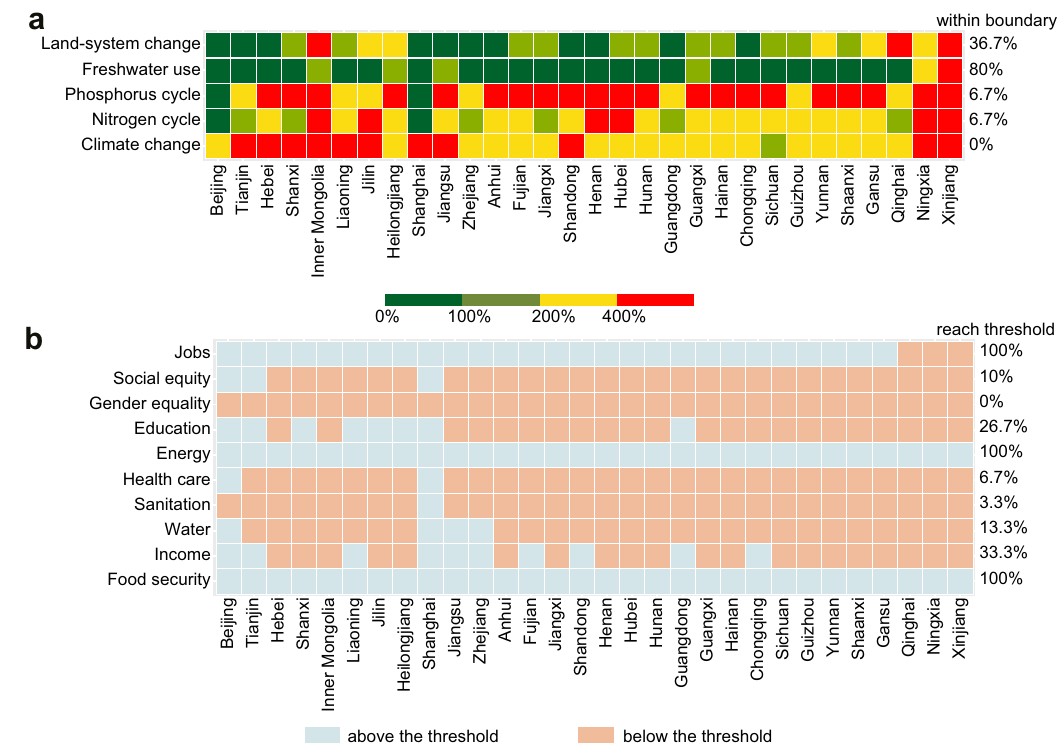
Fig. 4 | Sustainability performance of China ’ s provinces from 2000 to 2018. a Environmental performance with respect to per capita environmental boundaries. b Human well-being with respect to social